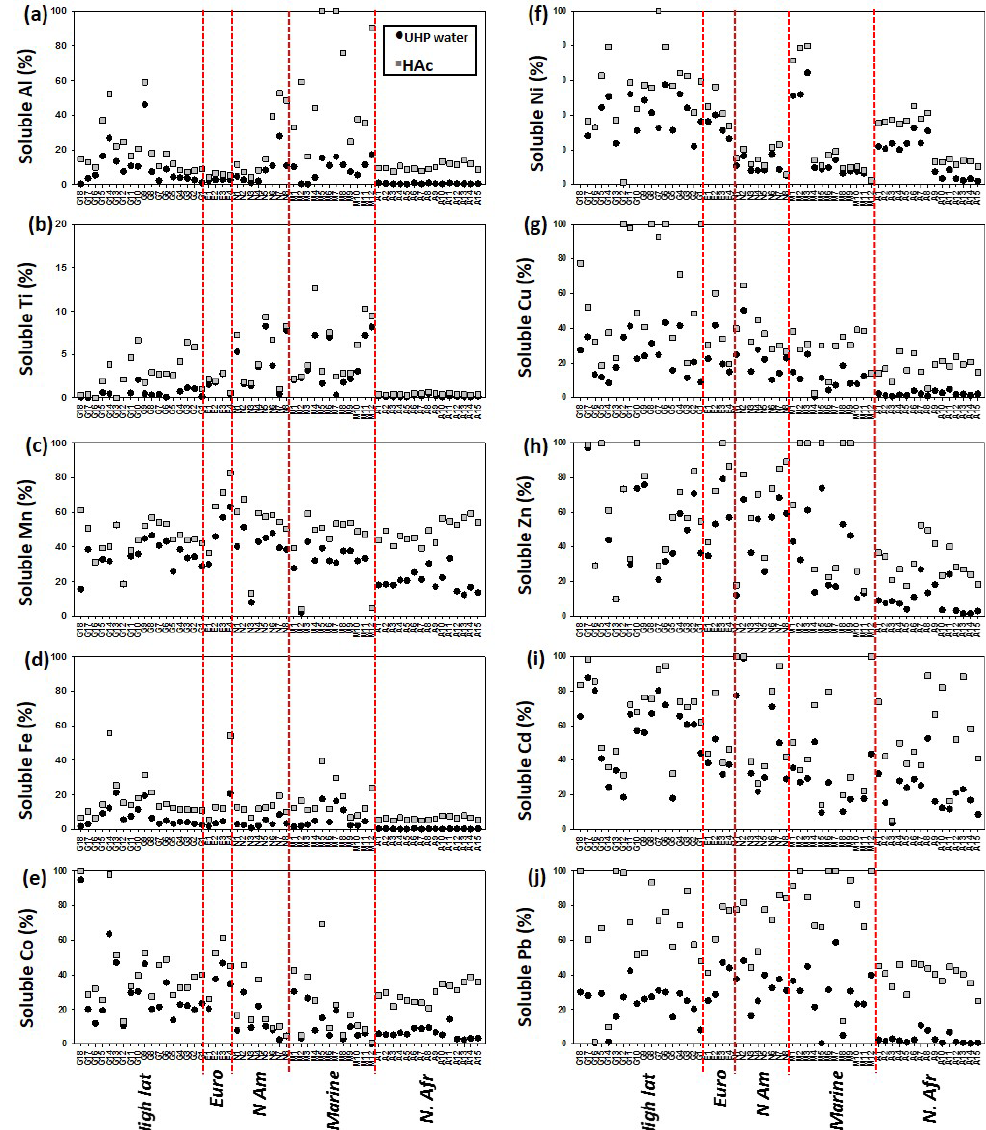
Figure 5. Solubility of Al, Ti, Mn, Fe, Co, Ni, Cu, Zn, Cd, and Pb following a UHP water leach (UHP water, black circles, calculated using Eq. 1) and a sequential leach of 25% acetic acid (HAc, grey squares, calculated using Eq. 2). The red vertical dashed lines represent the different aerosol source categories, as labelled in panel (b) . Note that Ti (panel b ) is highly insoluble and has a maximum value of <13%. The data for this figure are also presented in Fig. S4 as biplots of UHP water fractional solubility versus 25% acetic acid fractional